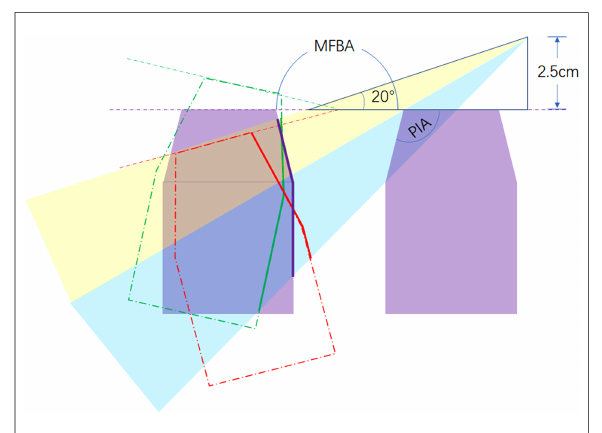
FIGURE 6 Effect of PIA and MFBA on the exposure of the Kawase or extended Kawase approach. PIA affects the range of bone removed by deboning the petrous apex and the sight angle added by the procedure (blue shade). MFBA affects the exposure range of the inner face of the petrosal bone in the contra side. When MFBA increases, the exposure range becomes smaller (purple line, MFBA=180°; red line, MFBA>180°; green line, MFBA<180°). MA is a parameter designed to combine the effects of PIA and MFBA. PIA, petrous inner angle; MFBA, middle fossa bottom angle; MA, manipulation